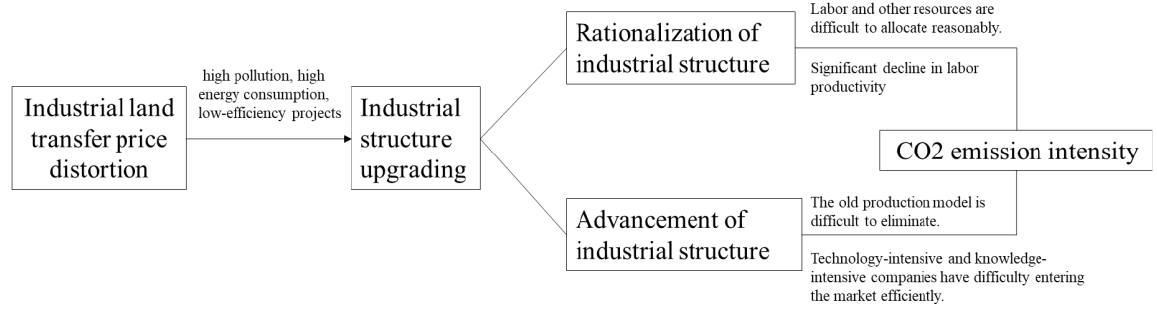
Figure 1. Intermediation effects based on industrial structure upgrading.